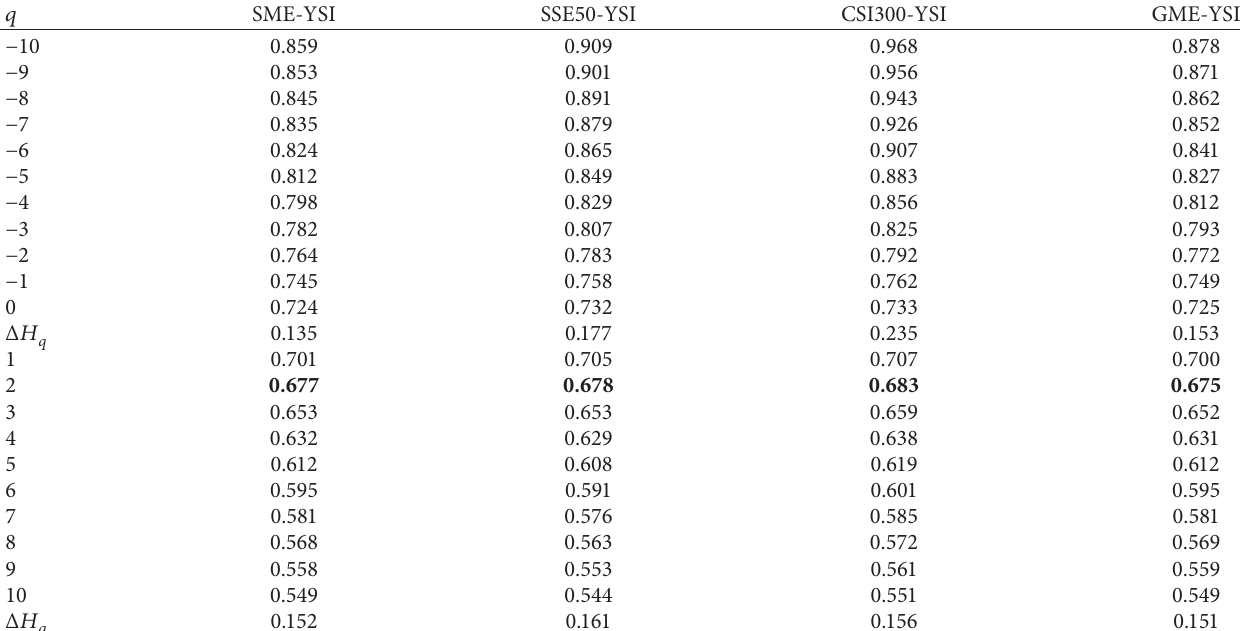
Table 5: Results of the MF-DCCA scaling exponent for Chinese stock market